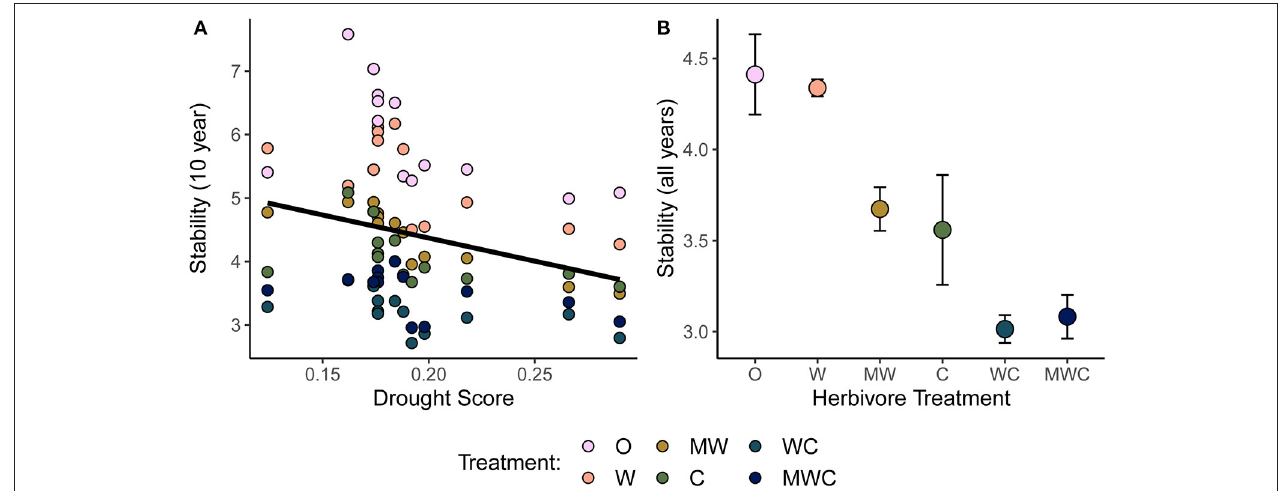
FIGURE 3 | Temporal stability ( µ / σ ) of herbaceous cover as a function of the drought score (A) and herbivore treatment (B) . Stability is calculated over a 10-year moving window in (A) in order to compare to the corresponding drought score of each time window. Higher drought score values indicate more severe drought. The black regression line in (A) is plotted as the predictor was included in the top model. In (B) stability is calculated over the full time series and points are colored by herbivore treatment. Herbivory patterns are consistent on a 10-year scale ( Supplementary Figure S2A ). Figures are based on raw data, but statistical models include random effects to account for spatial and temporal autocorrelation. See Table 1 for model details. Herbivore treatments (ordered by total herbivore biomass) are: O, No herbivores; W, Wild mesoherbivores; MW, Wild megaherbivores and wild mesoherbivores; C, Cattle; WC, Wild mesoherbivores and cattle; MWC, Wild megaherbivores, wild mesoherbivores, and cattle.